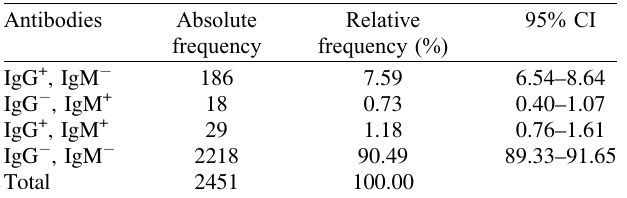
Table 2. Seroprevalence of anti- T. gondii IgG and IgM antibodies in